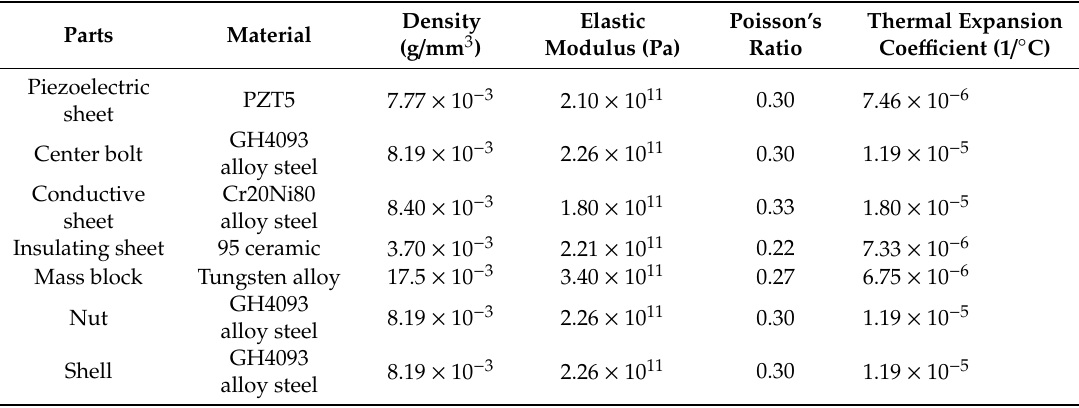
Figure 7. The demonstration of dangerous section. Table 2. Material properties of parts in sensing